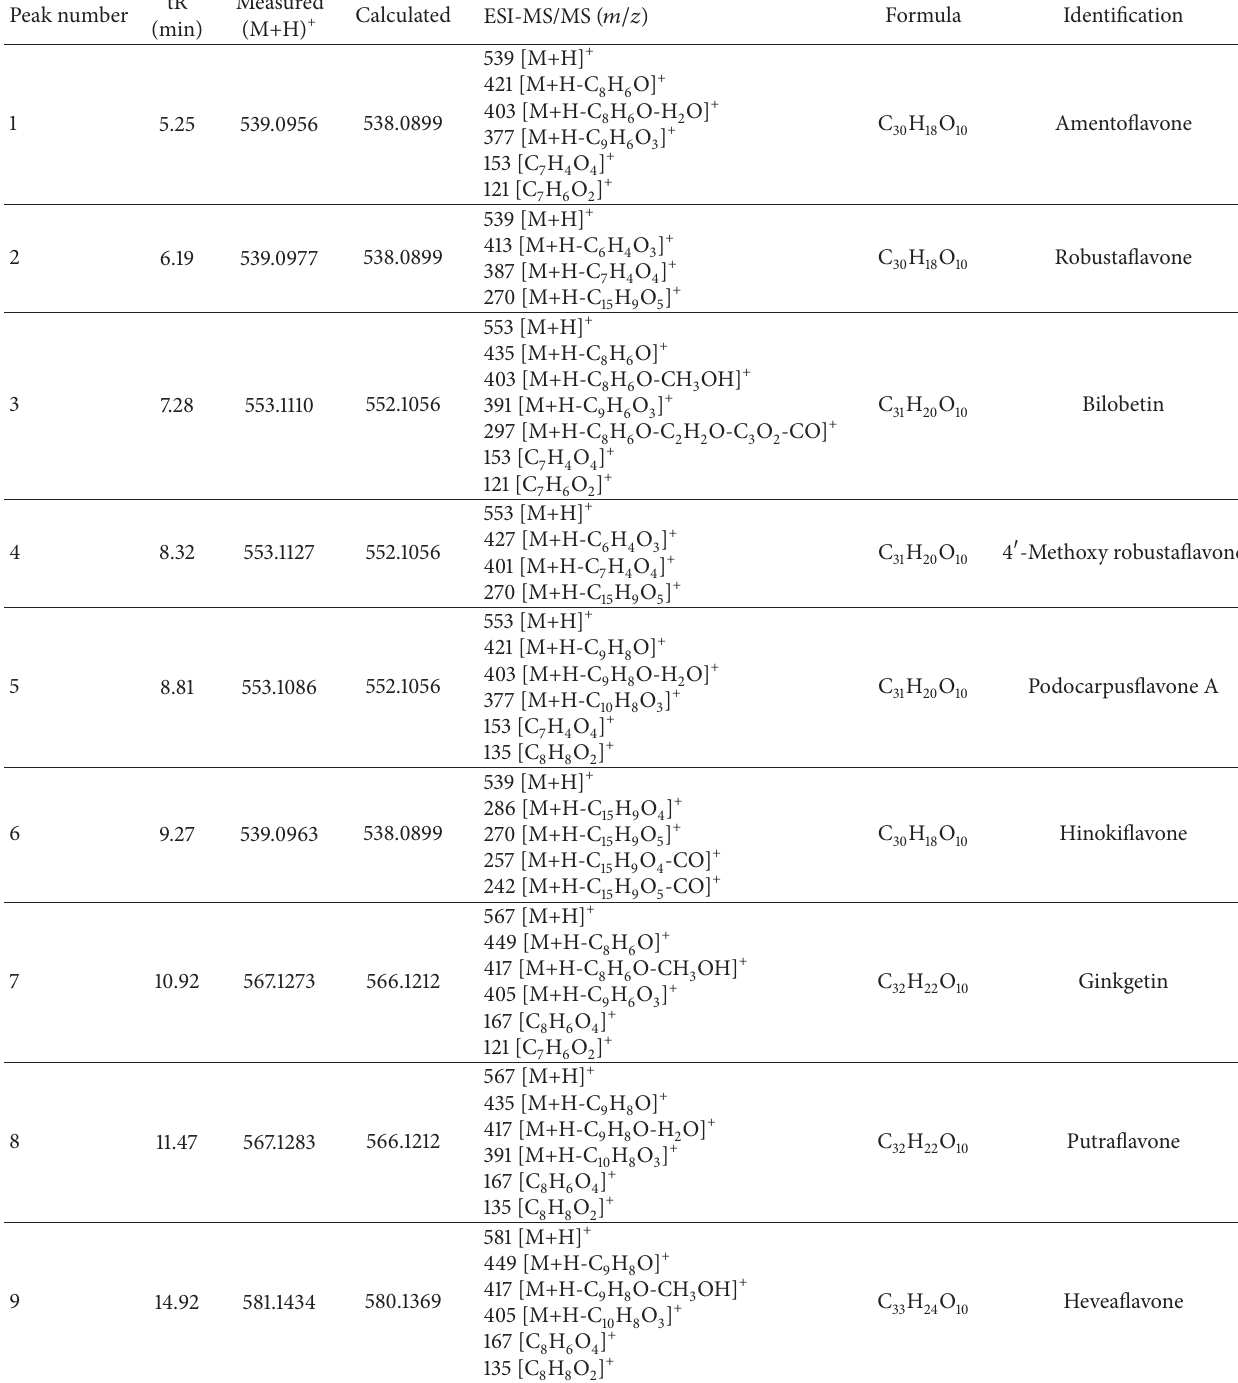
Table 3: Identification of 9 biflavonoids from Selaginella doederleinii by UPLC/Q-TOF MS/MS. Peak